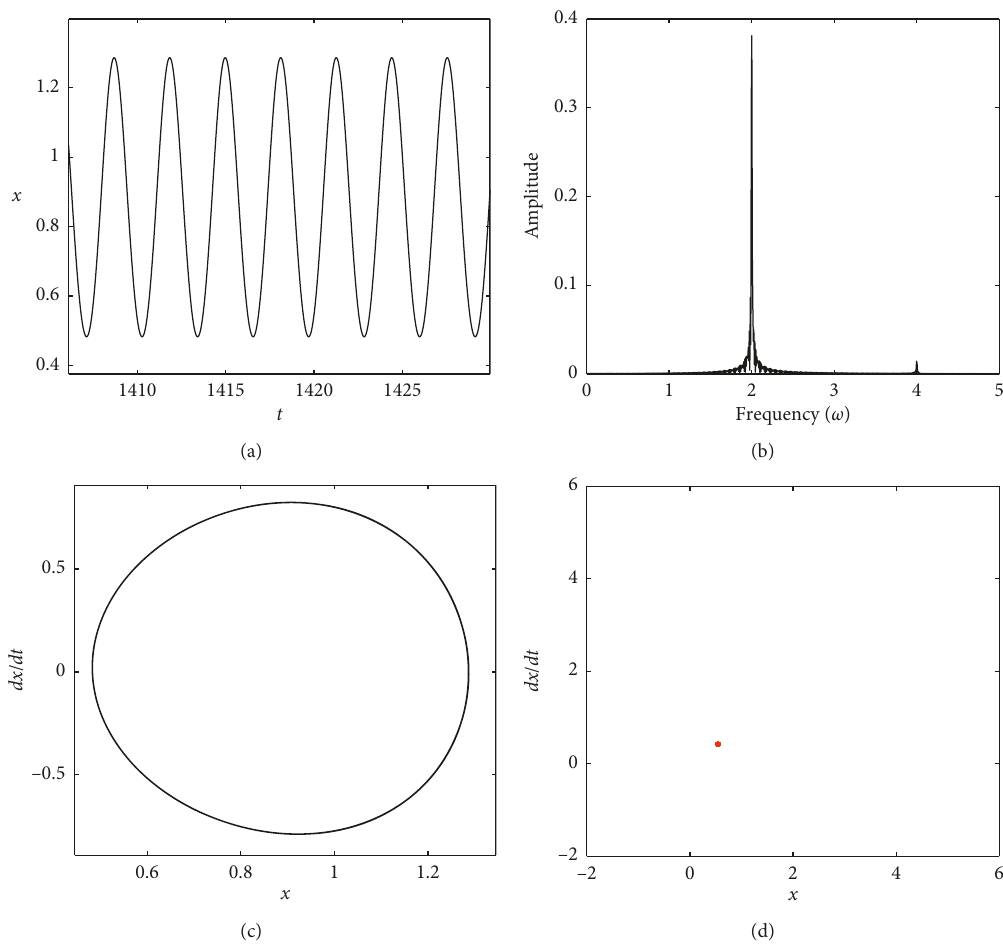
Figure 8: System response at ω � 2rad/s and F � 1N: (a) time history; (b) frequency spectrogram; (c) phase portrait; (d) Poincare maps.